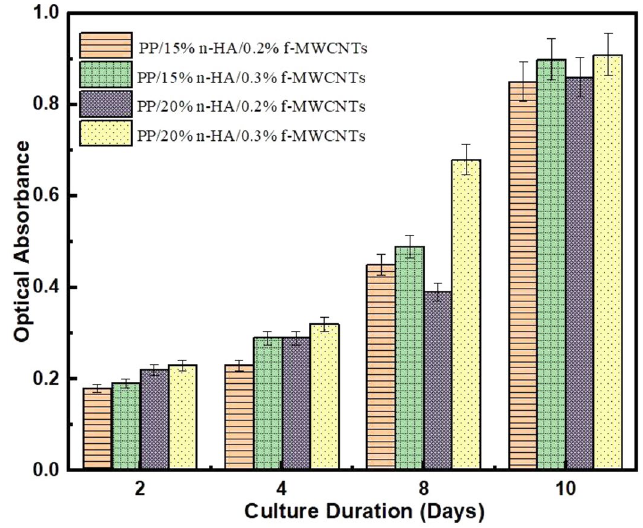
Figure 6. MTT assay analysis.